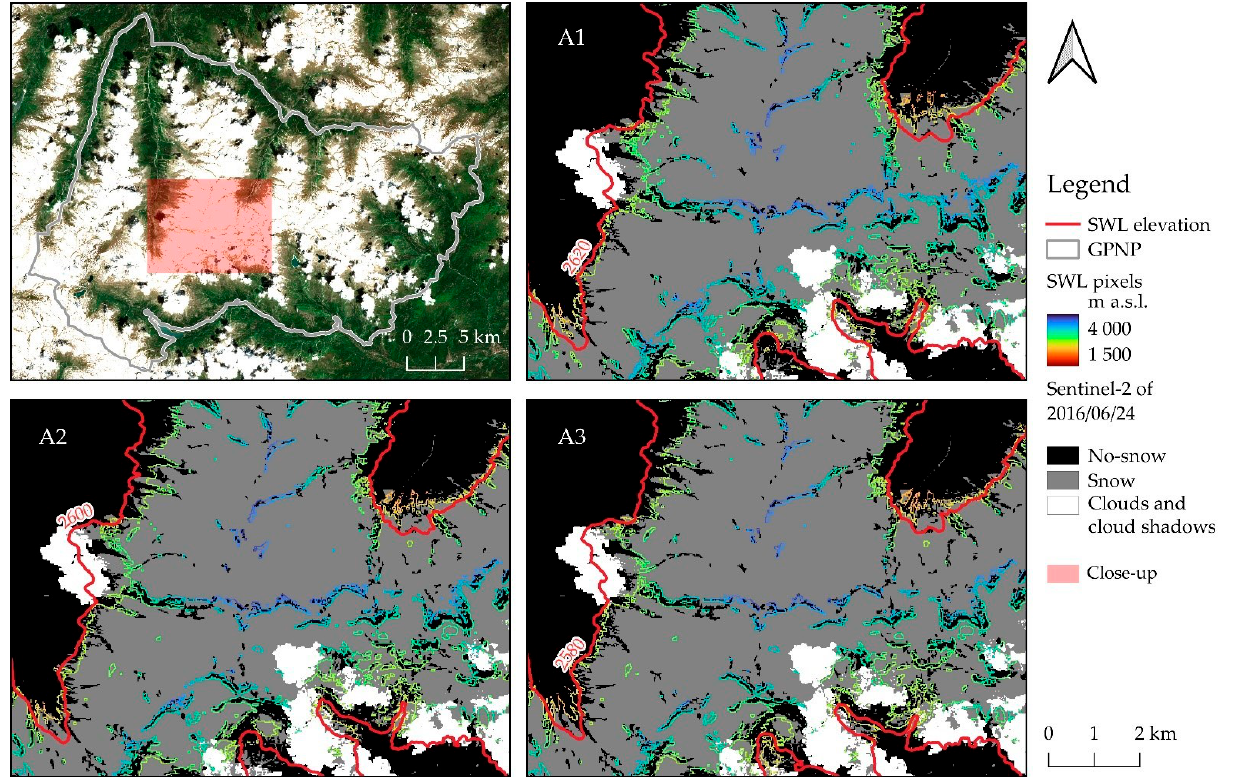
Figure 8. Example of the snowline (SWL) elevation and pixels predicted against the real S2 scene acquired on 24 June 2016. Top left : natural color S2 with close-up area. A1 – A3 : close-up with real S2 SCE map in background and SWL pixels and elevation computed, respectively, with A1, A2, and A3